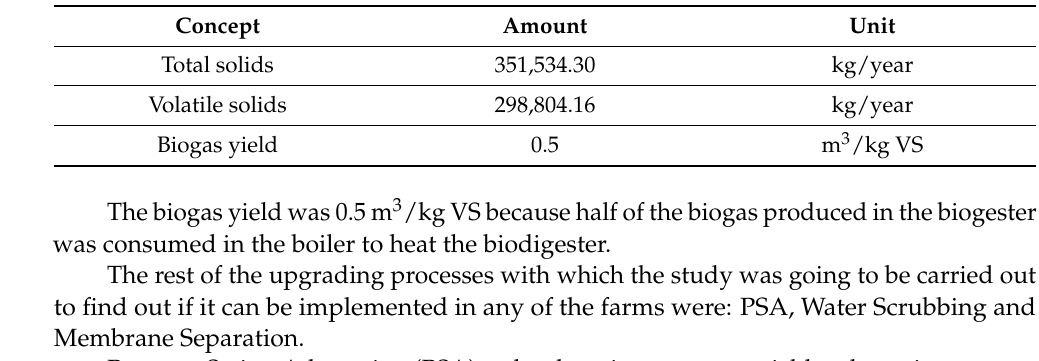
Table 3. Slurry characteristics. Laboratory